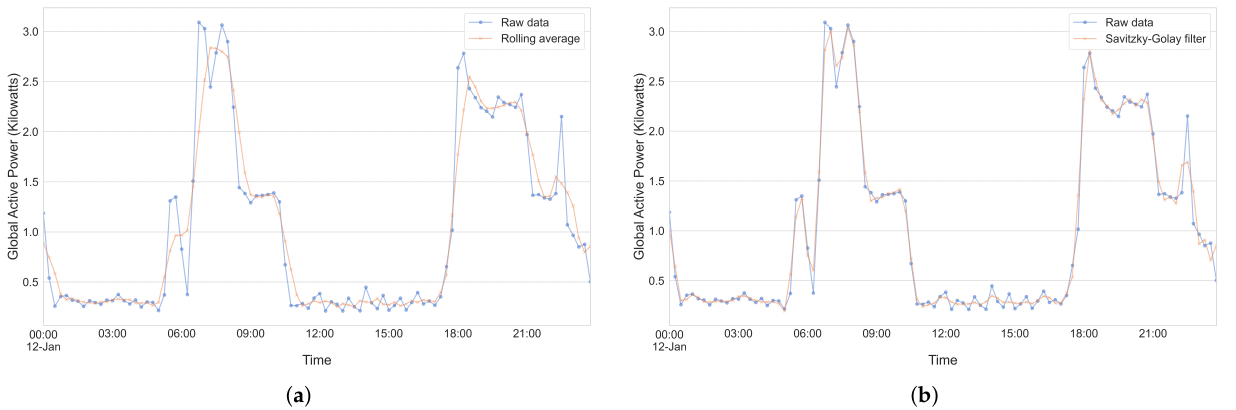
Figure 7. Illustration of the application of the moving average method and the Savitzky–Golay filter method to smooth a subset of our raw data. ( a ) Application of the moving average method with a window size of 3. ( b ) Application of the Savitzky–Golay filter method with a polynomial order of 3 and a window size of 5.